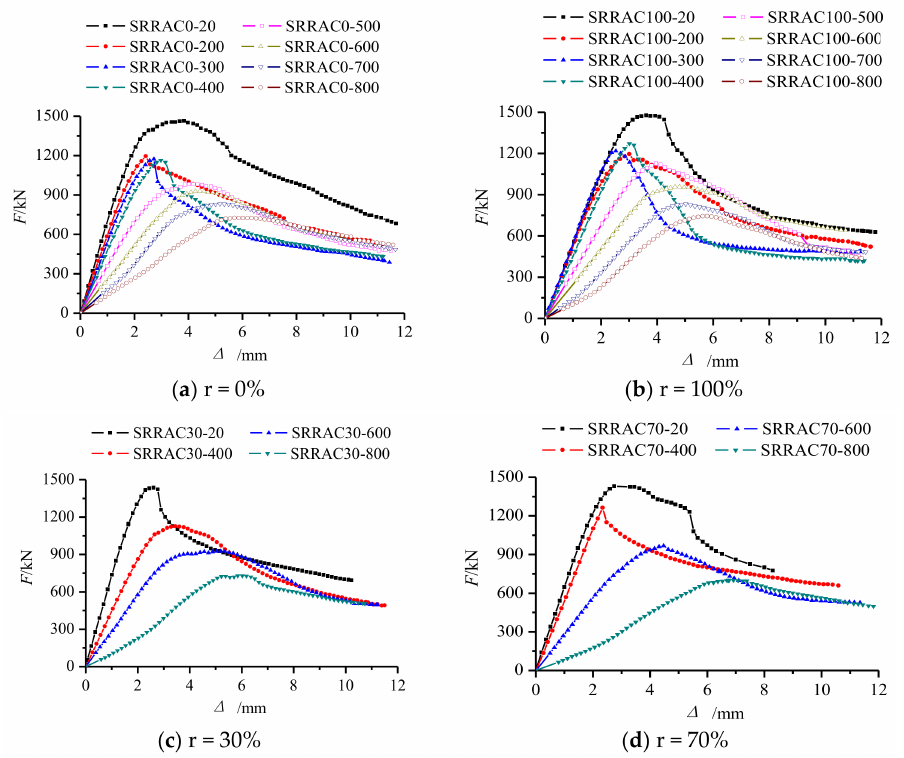
Figure 11. Load-displacement curve of SRRAC columns.